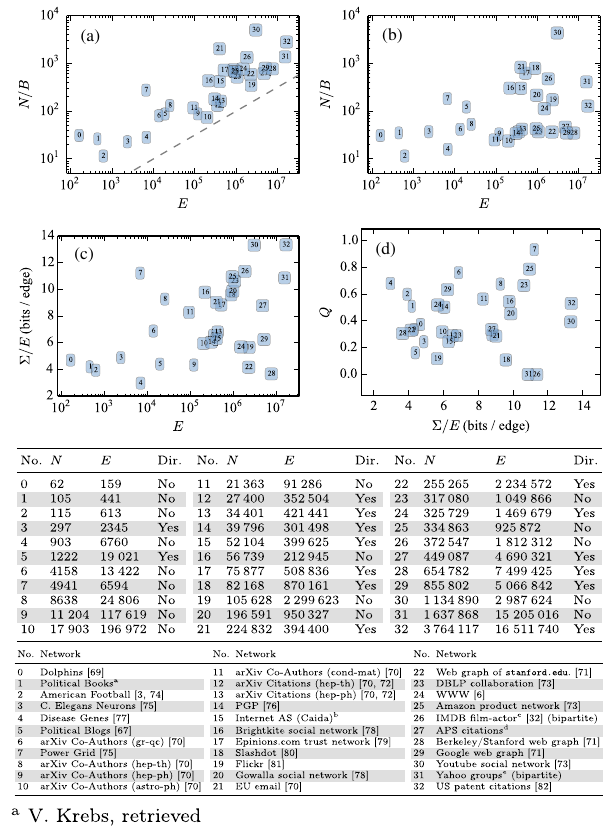
FIG. 8. (a) The average block size N=B obtained using the nonhierarchicalmodel,asafunctionof E ,fortheempiricalnetworks listed in the bottom table (the Dir. column specifies whether a given network is directed). The dashed line shows a sameas(a)butwiththenestedmodel.(c)Thedescriptionlength Σ =E forthenestedmodelasafunctionof E .(d)Thevalueofmodularity Q as function of Σ =E , for the nested